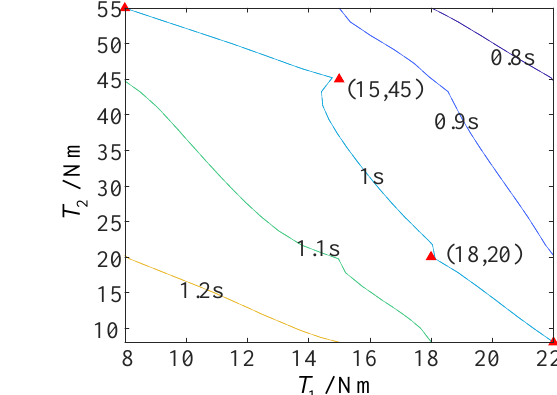
Figure 23. The curve of driving torque and deployment time of folding wing at an airspeed of 30 m/s (fixed-axis – non-fixed-axis stepwise deployment mode).